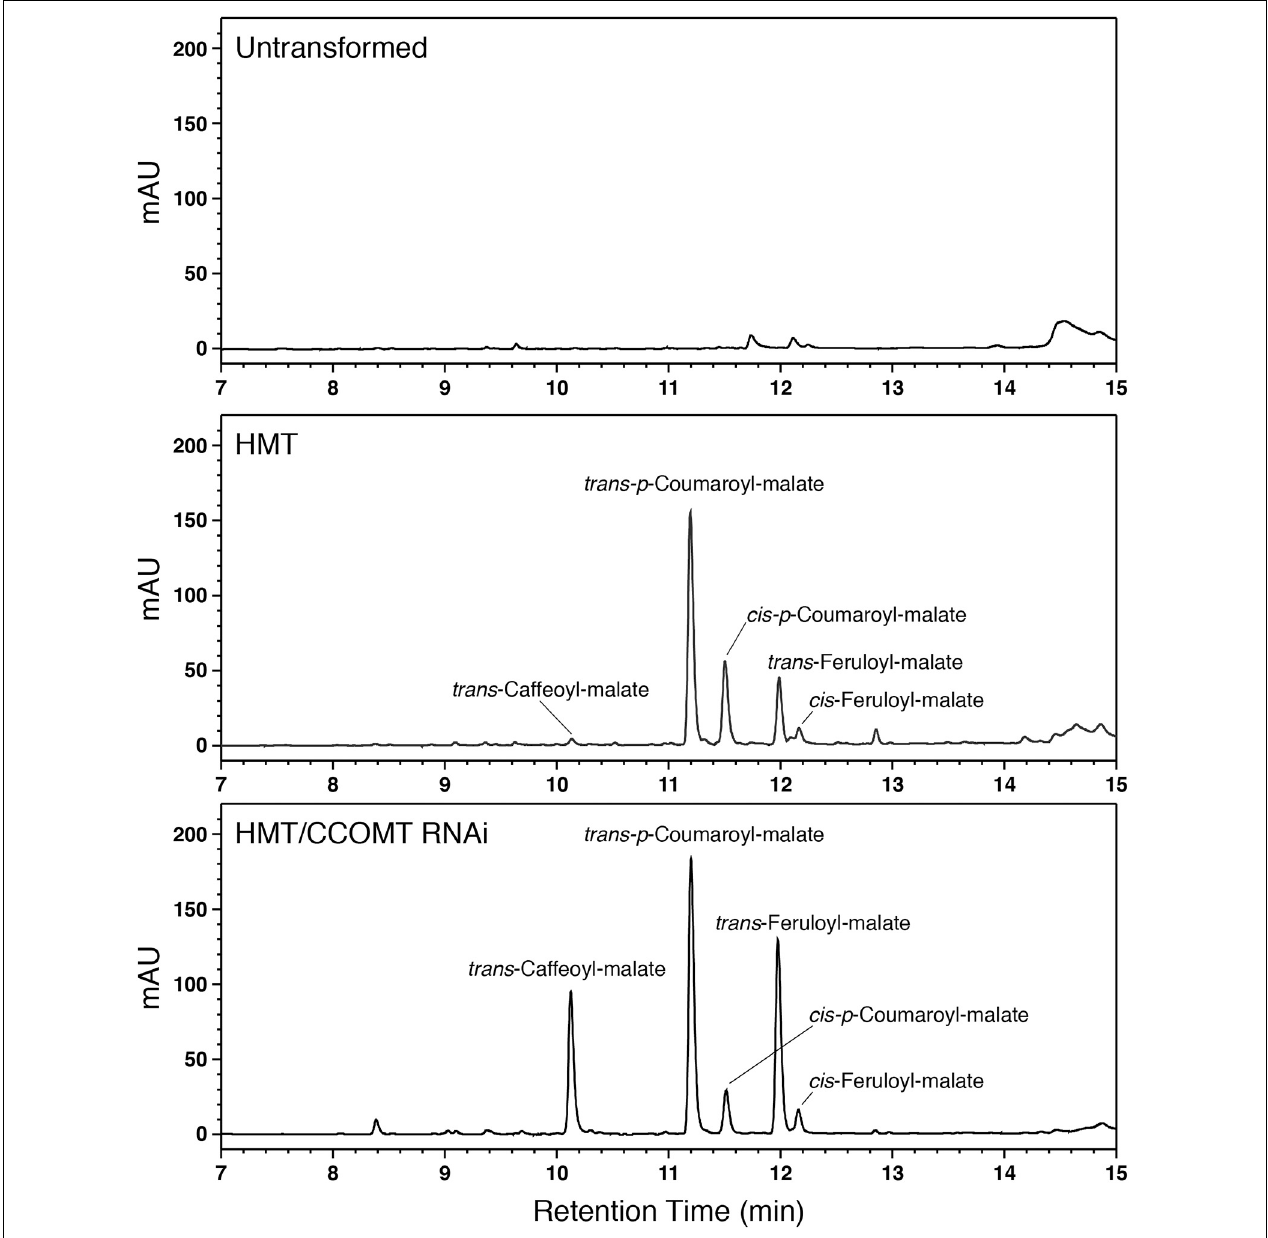
FIGURE 2 | LC separation with PDA detection (310–325 nm) of alfalfa phenolics from leaves of untransformed wild type (top), HMT-expressing (middle), or HMT-expressing/CCOMT RNAi (bottom) alfalfa. Identified hydroxycinnamoyl-malate esters are indicated.